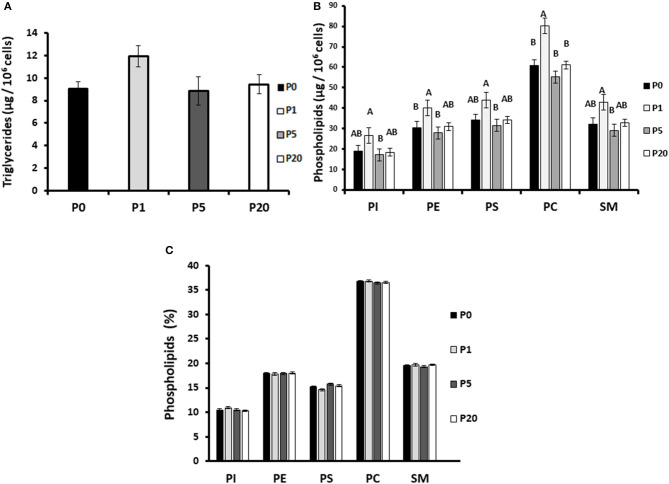
Progesterone affects lipid content and composition in mammary epithelial cells. Mammary epithelial cells were treated with progesterone at 0, 1, 5, and 20 ng/ml (P0, P1, P5, and P20, respectively) for 24 h. After treatment, cells were harvested and PL content and composition was determined by HPLC-ELSD. (A) Cellular triglyceride content did not differ between treatments. (B) Phospholipid concentration in mammary epithelial cells was determined. Cells treated with 1 ng/ml progesterone had greater PL content whereas cells treated with 5 ng/ml progesterone had lower phospholipid content relative to the control. (C) Phospholipid composition (weight %) in the mammary epithelial cells did not differ between treatments. PI, phosphatidylinositol; PE, phosphatidylethanolamine; PS, phosphatidylserine; PC, phosphatidylcholine; SM, sphingomyelin. Data are presented as mean ± SD. Different letters indicate significant differences in the level of p ≤ 0.05.